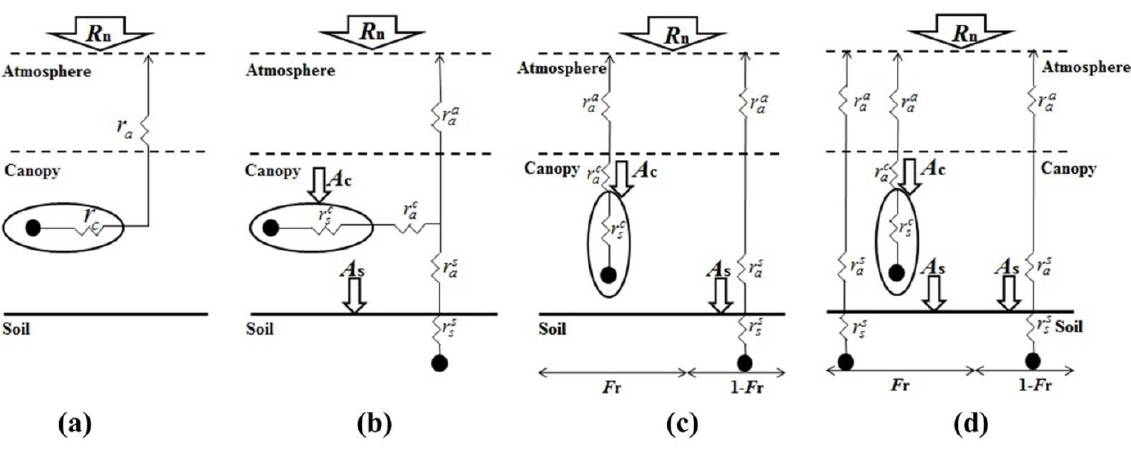
Figure 1. Structure of the Penman-Monteith model ( a ); Shuttleworth-Wallace model ( b ); Two-Patch model ( c ); and Hybrid dual-source model ( d ). The nomenclature used is given in Section